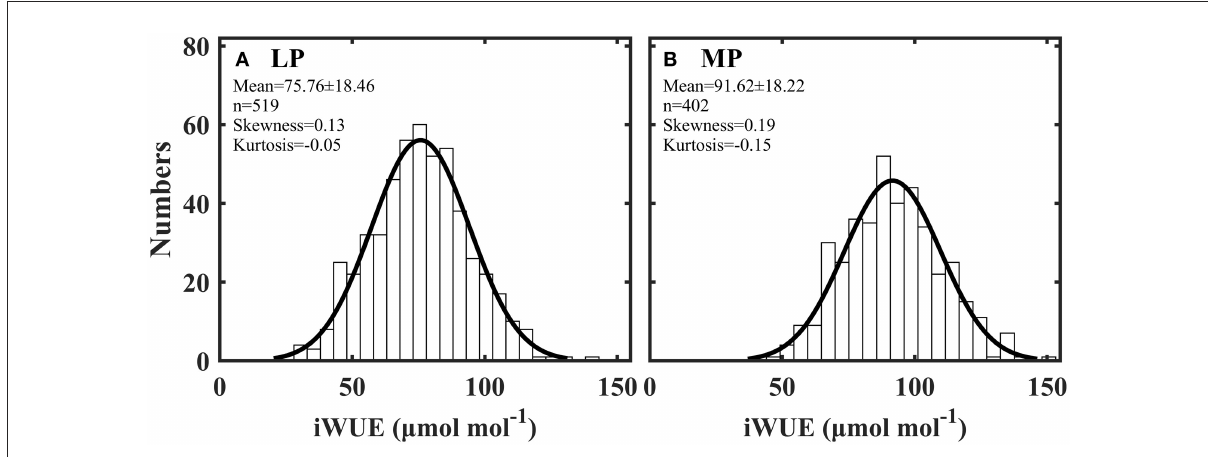
FIGURE2 Frequency distribution of intrinsic water use efficiency (iWUE) in Loess Plateau (LP) (A) and Inner Mongola Plateau (MP) (B)